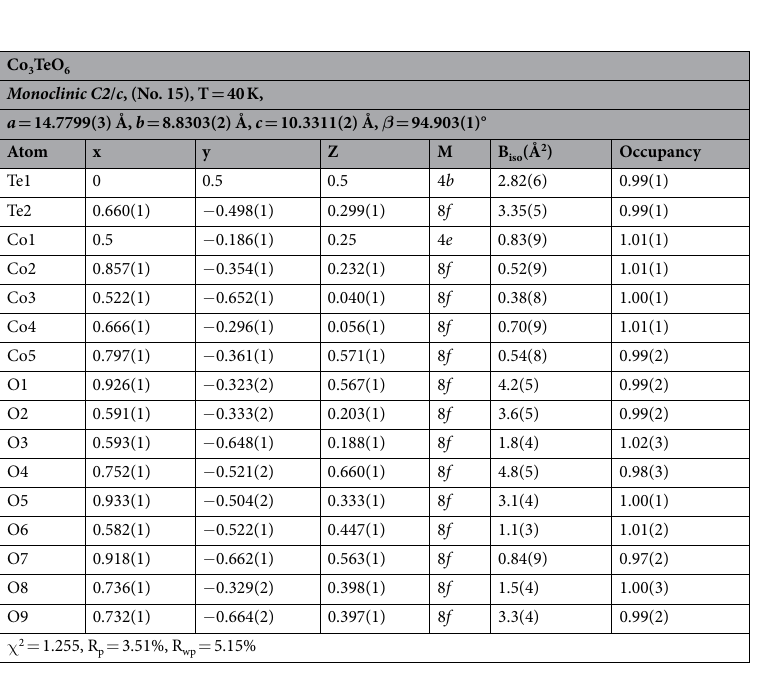
Table 1. Refinement of the x-ray data at 40 K. The refinements are in excellent agreement with the refined neutron diffraction data 17 .